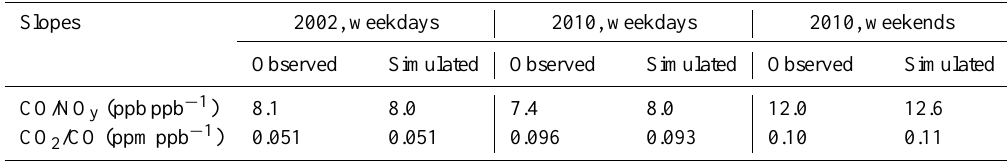
Table 4. Observed and simulated slopes between CO, NO y and CO 2 mixing ratios in 2002 and 2010 during weekdays and weekends in the LA